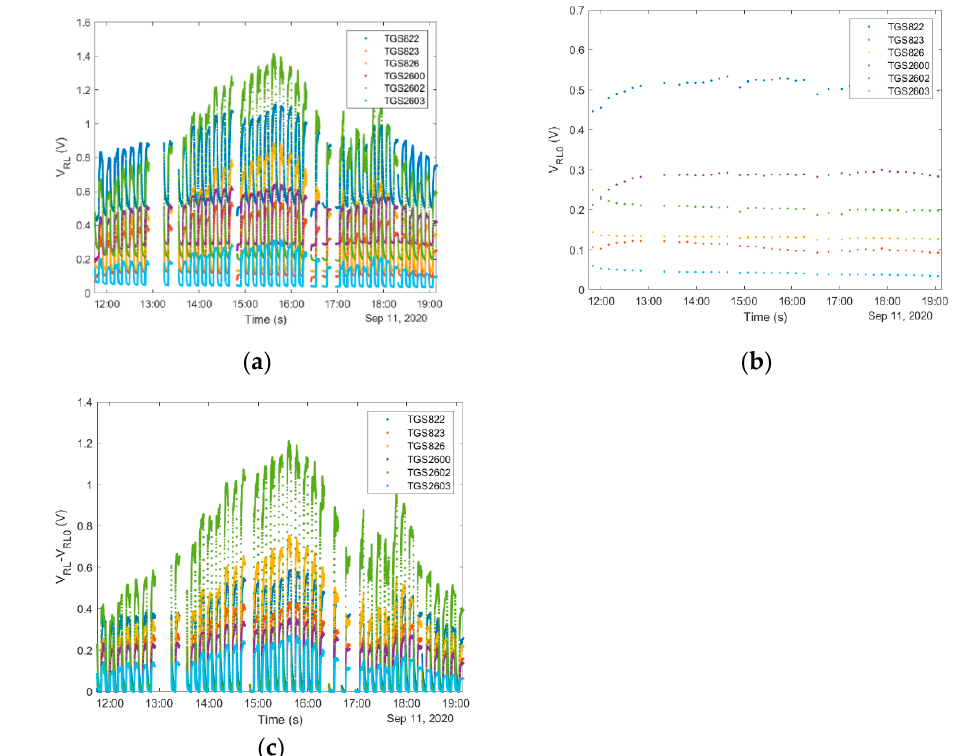
Figure 5. Results of bee colony monitoring using ‘ exposure-cleaning ’ operation. On the measurement day, the beehive air did not display any pattern of temporal variation, which could be associated with the measurement system operation. In particular, sensor signals did not decrease regularly in time; ( a ) raw sensor signals, ( b ) baseline for subsequent ‘ exposure-cleaning ’ operations, and ( c ) sensor signals after differential baseline correction.